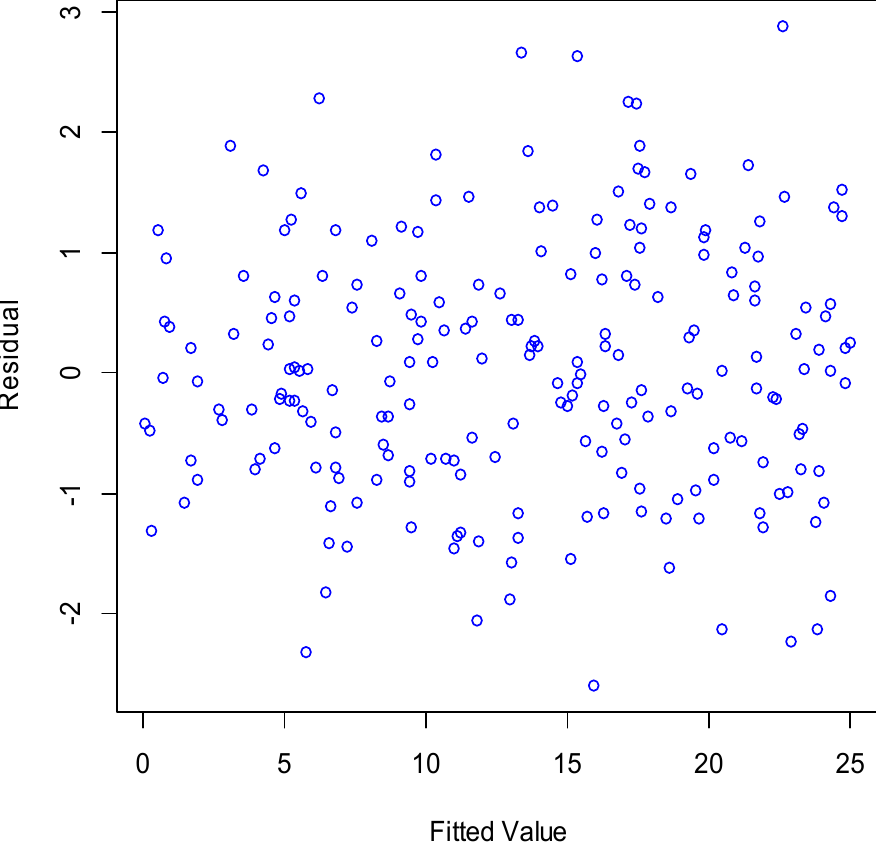
Figure 3. Plot of residuals versus the fitted values for the BMLR model.